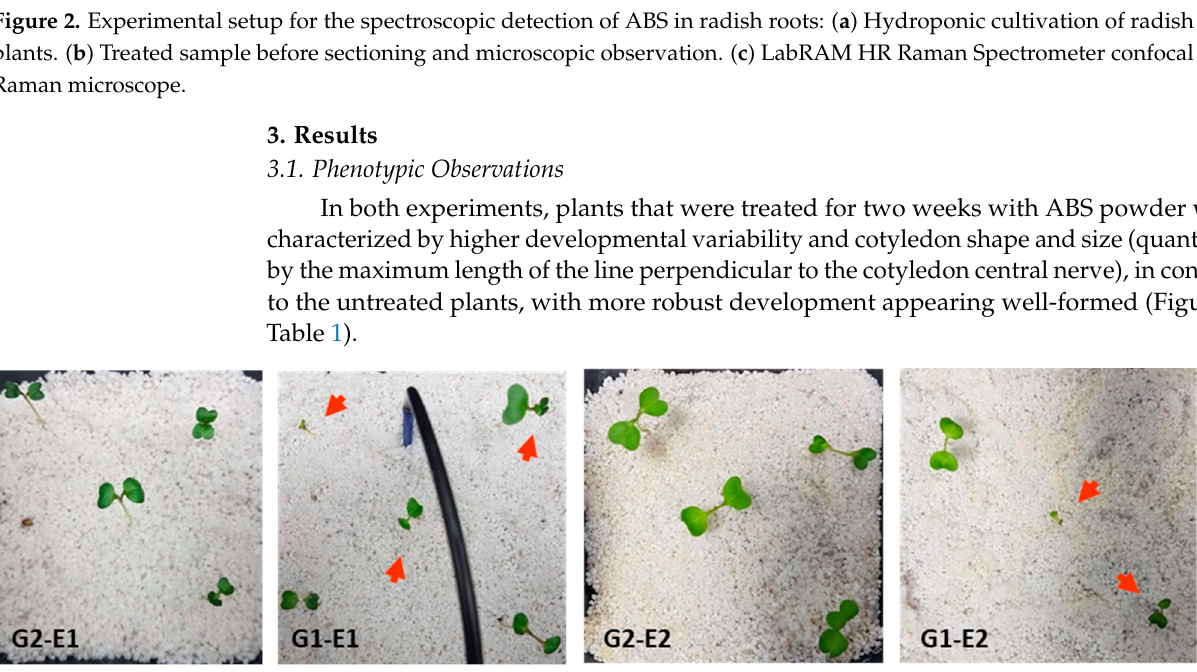
Figure 2. Experimental setup for the spectroscopic detection of ABS in radish roots: ( a ) Hydroponic cultivation of radish plants. ( b ) Treated sample before sectioning and microscopic observation. ( c ) LabRAM HR Raman Spectrometer confocal Raman microscope.